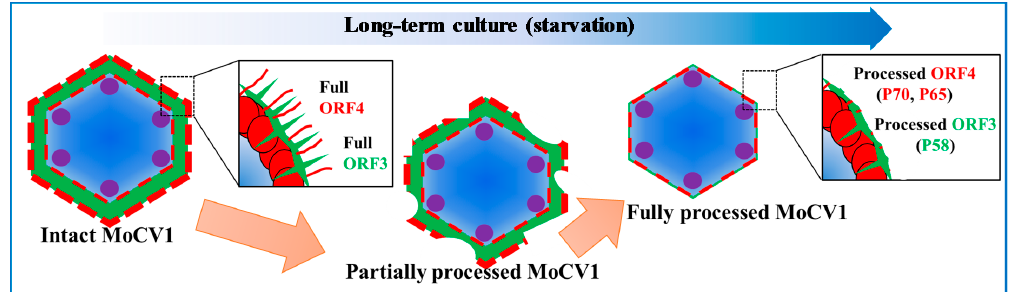
Figure 6. Model for partial degradation of the ORF3 and ORF4 proteins. In the early stage of culture, the MoCV1-A viral particles contained full-length ORF3 and ORF4 proteins. After long-term culture and nutrient depletion, the viral particles were composed of partially degraded ORF3 and ORF4 proteins.